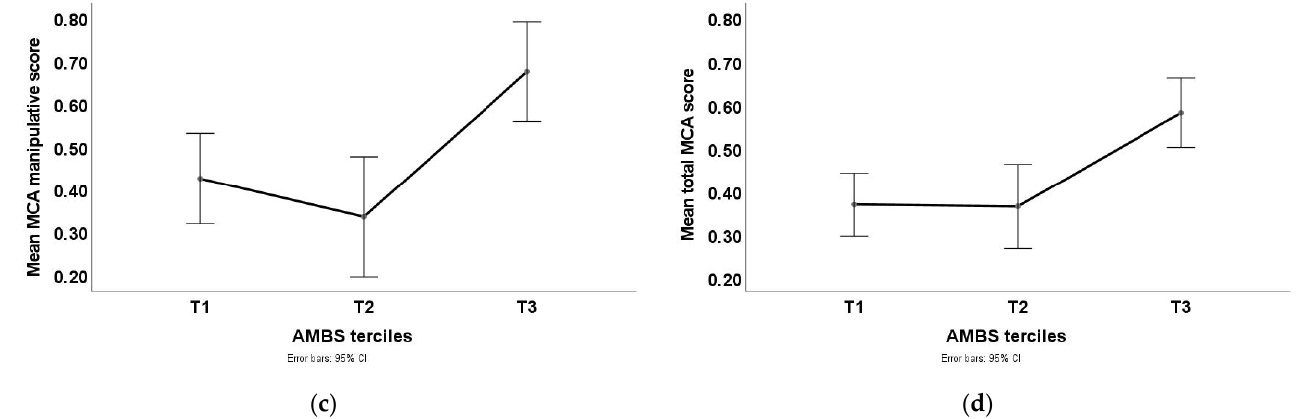
Figure 1. AMBS classification groups regarding MCA values: ( a ) Mean scores of the AMBS terciles in the stability component. ( b ) Mean scores of the AMBS terciles in the locomotor component. ( c ) Mean scores of the AMBS terciles in the manipulative component. ( d ) Mean scores of the AMBS terciles in Total Motor Competence.